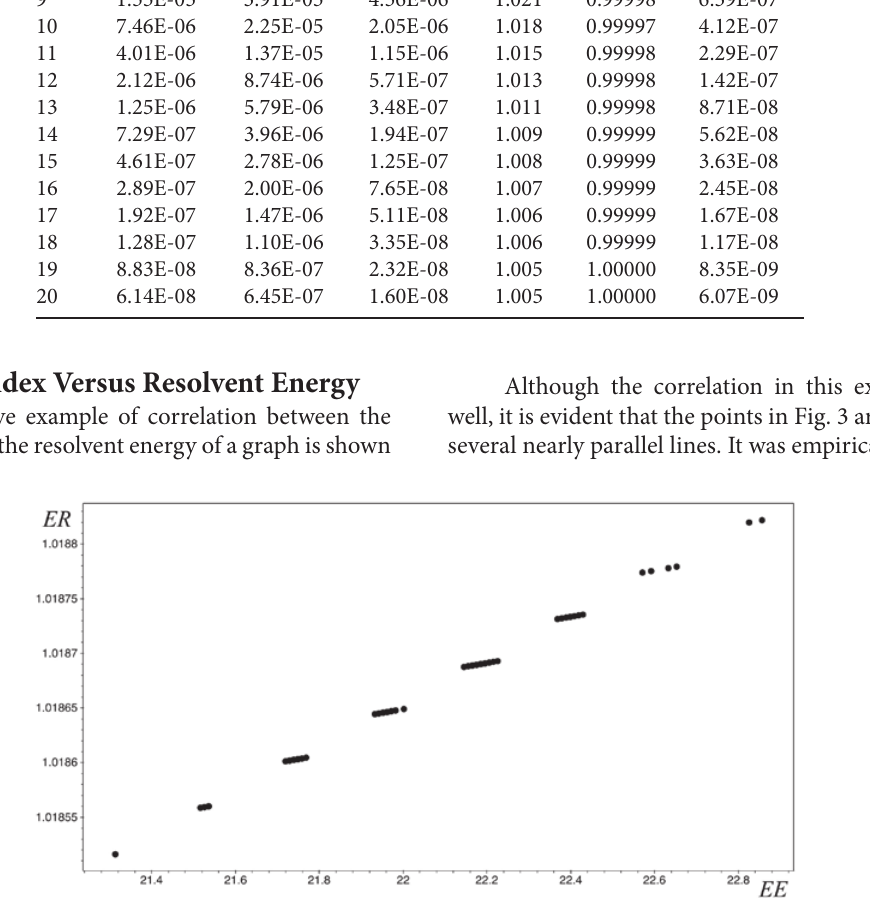
Figure 3. Correlation between the Estrada index and the resolvent energy of graph for all chemical trees with 10 vertices.